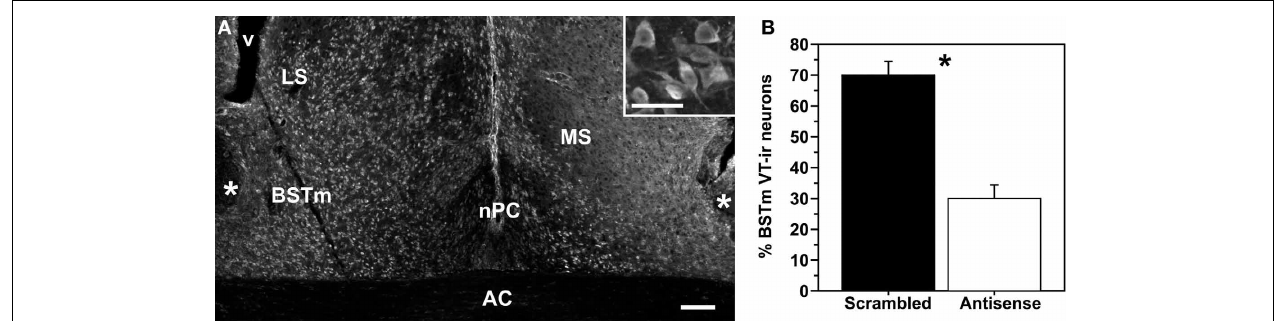
FIGURE 1 | (A) Representative knockdown of VT production as shown in a colchicine-treated pilot subject that received infusions of scrambled oligonucleotides in the left hemisphere and VT antisense oligonucleotides in the right hemisphere. Inset : Magnified view of VT-ir neurons in the BSTm. Scale bar = 100 µ m; 50 µ m for inset. Abbreviations: AC, anterior